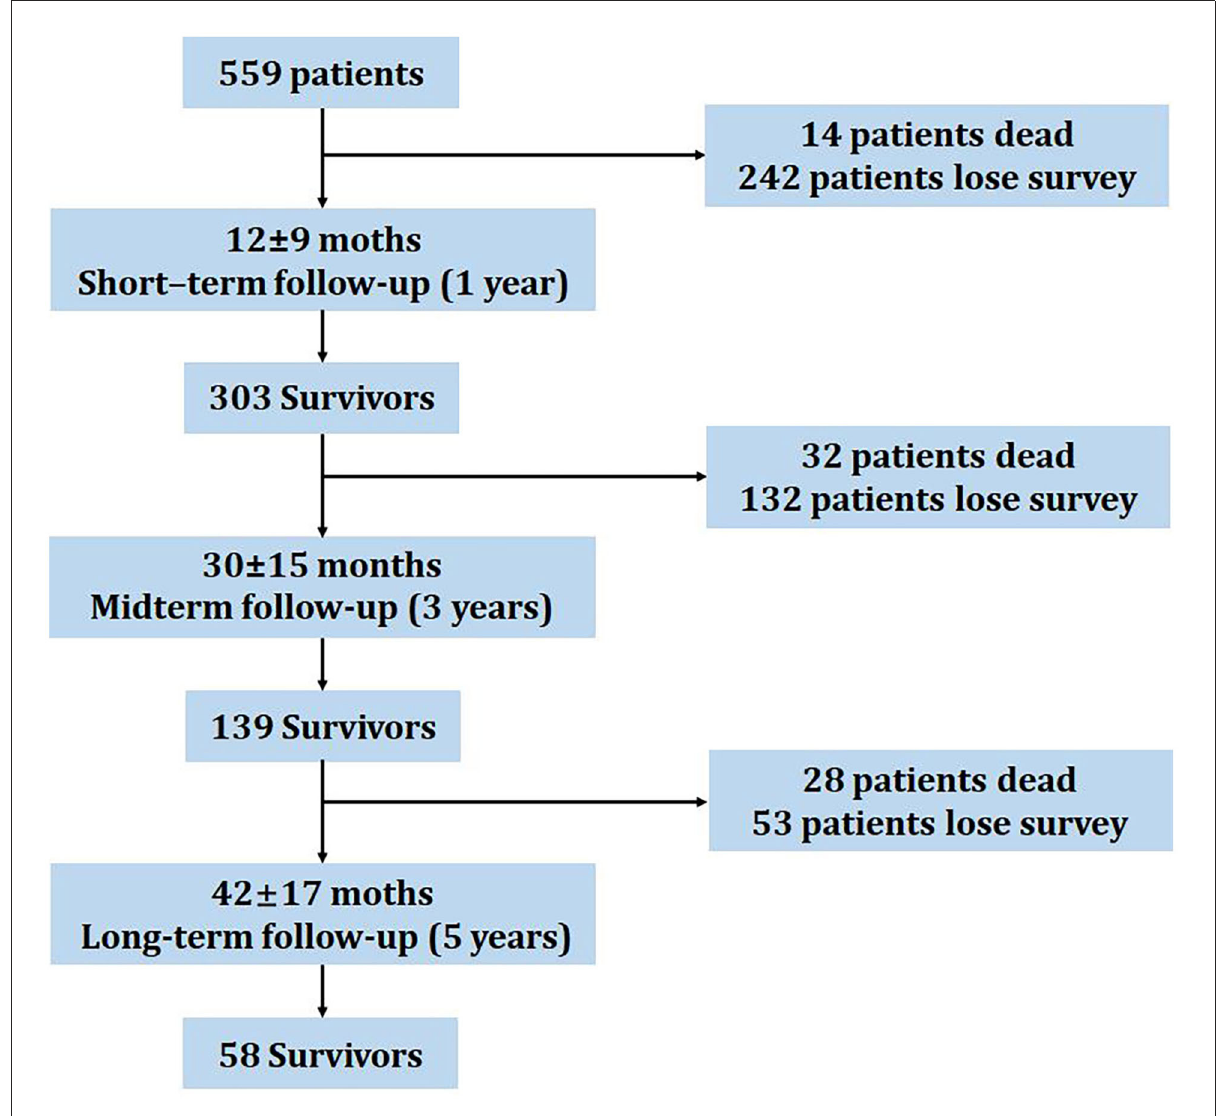
FIGURE1 Study patient flow